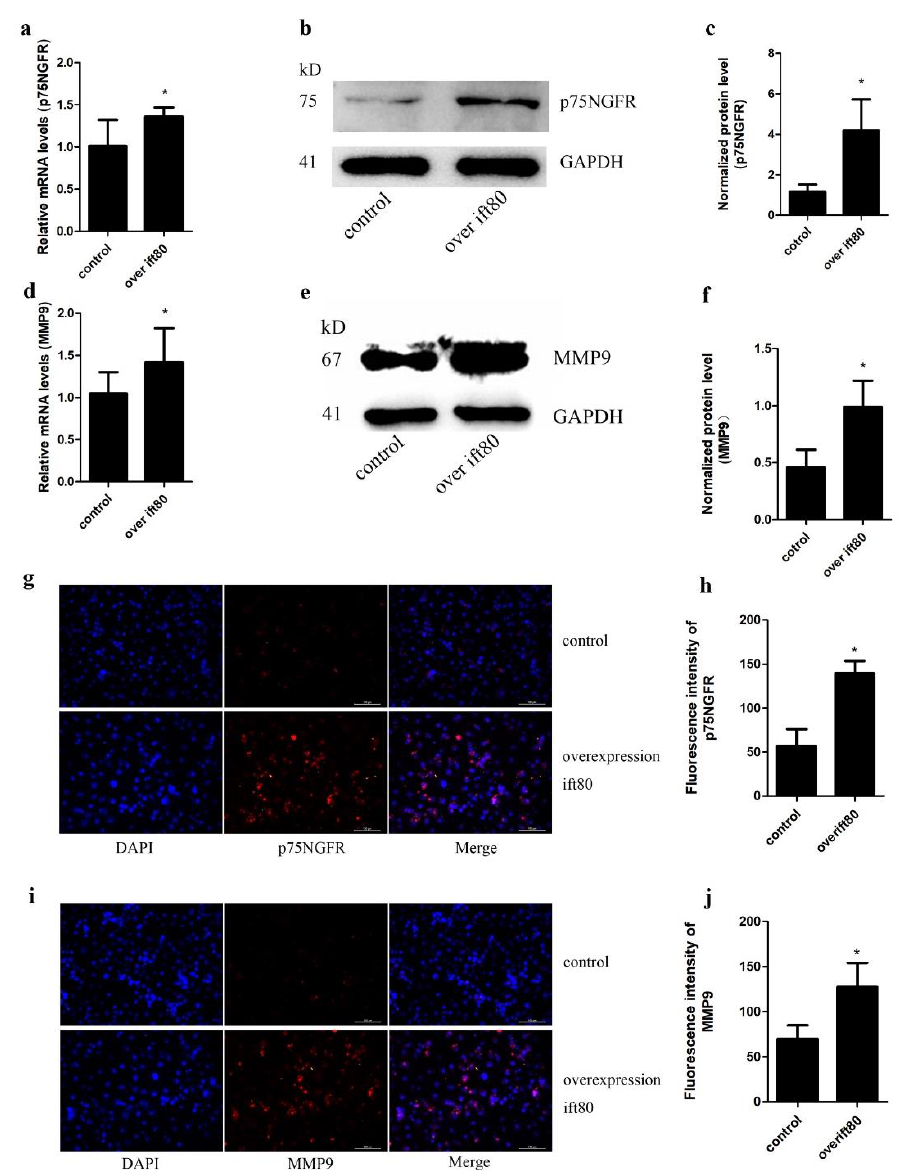
Figure 4. Increased IFT80 expression increases the protein expression levels of p75NGFR and MMP9 in SGC-7901 cells. ( a ) qRT-PCR analysis of p75NGFR expression in control cells and IFT80-overexpressing cells. The expression of p75NGFR is normalized to GAPDH expression. ( b ) The expression of p75NGFR was evaluated by Western blot analysis. GAPDH was used as an internal control. ( c ) Quantitative analysis of p75NGFR protein levels from immunoblots in ( b ). The protein levels of p75NGFR were normalized to GAPDH. ( d ) qRT-PCR analysis of MMP9 expression in control cells and IFT80-overexpressed cells. ( e ) The MMP9 protein expression was assessed by Western blot analysis. ( f ) Quantitative analysis of MMP9 protein levels from immunoblots in e. The protein levels of MMP9 were normalized to GAPDH. ( g ) The expression of p75NGFR was assessed by immunofluorescence in control cells and IFT80-overexpressed cells. Cells are stained with anti-p75NGFR antibody (red) and nuclei were marked with DAPI (blue) (200 × ). ( h ) Quantification of the fluorescence intensity shown in ( g ). Data represent the mean ± SEM. N = 3. * P < 0.05, control vs. overexpression of ift80. ( i ). The expression of MMP9 was evaluated by immunofluorescence in control cells and IFT80-overexpressed cells. Cells are stained with anti-MMP9 antibody (red) and nuclei were marked with DAPI (blue) (200 × ). ( j ). Quantification of the fluorescence intensity shown in ( i ). ( N = 3, * P < 0.05, control vs. overexpression of ift80).